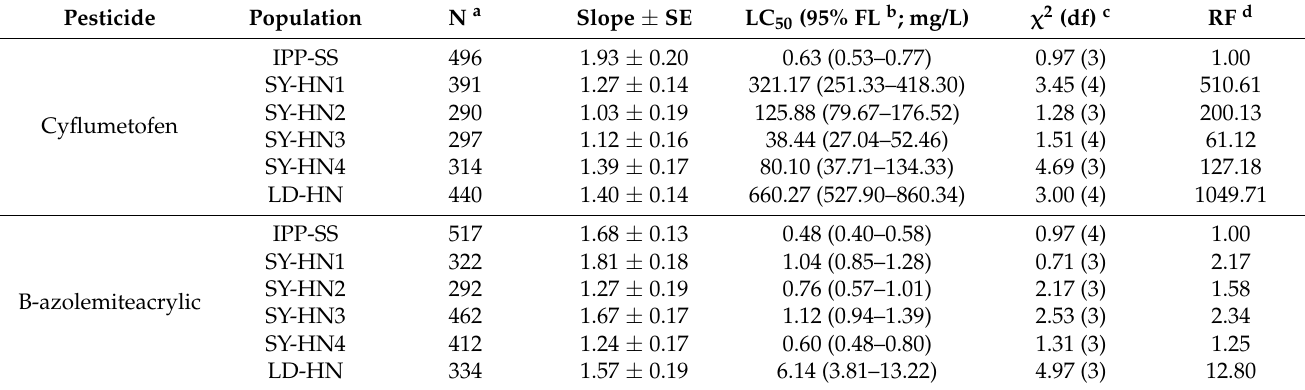
Table 3. Resistance of T. urticae populations from Hainan to recently developed pesticides.